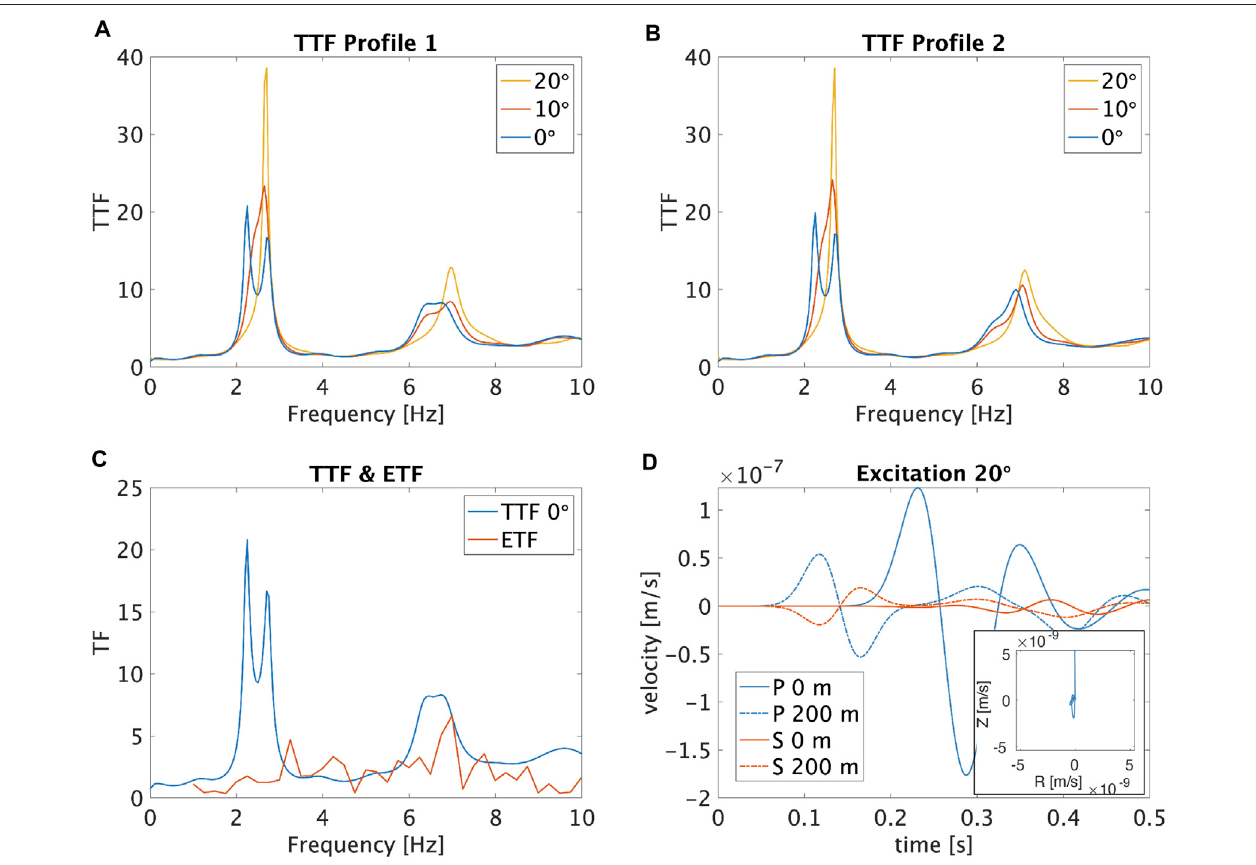
FIGURE 11 | (A) Theoretical transfer functions (TTF) for P-wave velocity Pro fi le 1 for various angles of incidence. (B) TTF for P-wave velocity Pro fi le 2 for various anglesofincidence. (C) Theoretical(blue)andempirical (red)transferfunctionforboreholeG19. (D) Excitation(in velocity)fortheP-wavesontheverticalplane(blue)and S-waves on the horizontal plane (red) at 200 m (dashed) and at the surface (solid) with θ of 20 ° . The inset depicts the related particle motion at surface for the P-wave arrival time window.